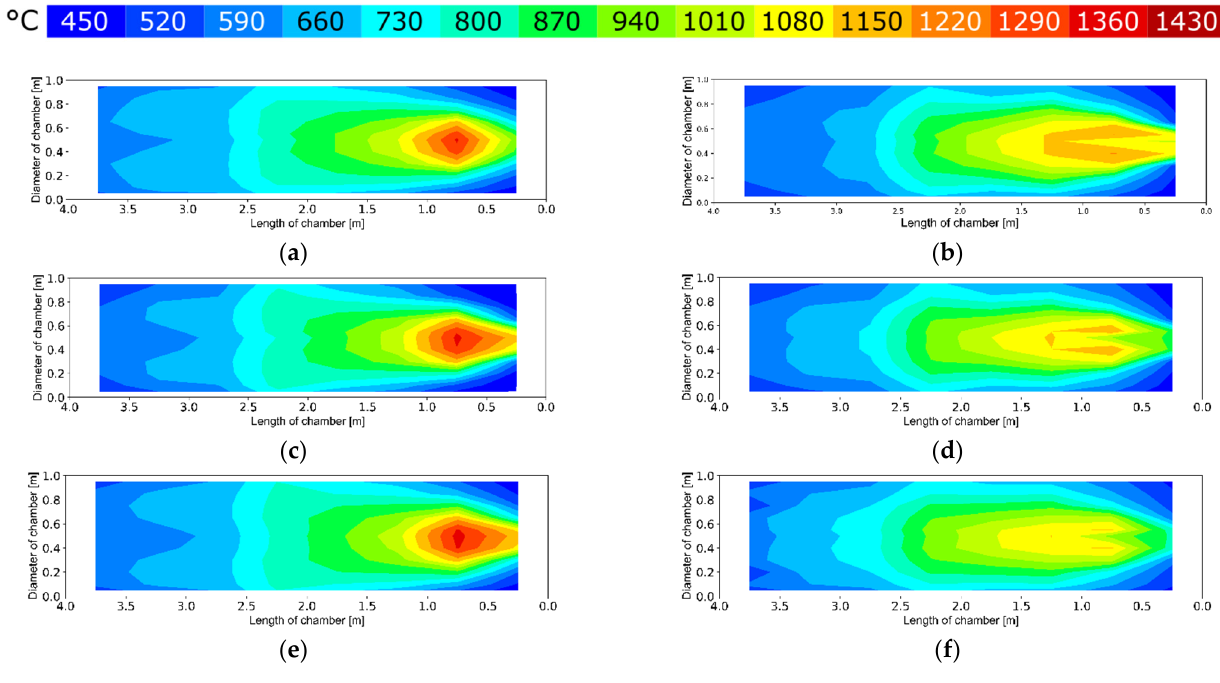
Figure 8. Influence of inert gas addition on flame temperatures—burner with staged fuel distribu- tion—Burner A: ( a ) Primary regime without inert gas addition; ( b ) secondary regime without inert gas addition; ( c ) primary regime with the addition 10 m N3 /h of N 2 ; ( d ) secondary regime with the addition 10 m N3 /h of CO 2 ; ( e ) primary regime with the addition 10 m N3 /h of CO 2 ; ( f ) secondary regime with the addition 10 m N3 /h of CO 2 .